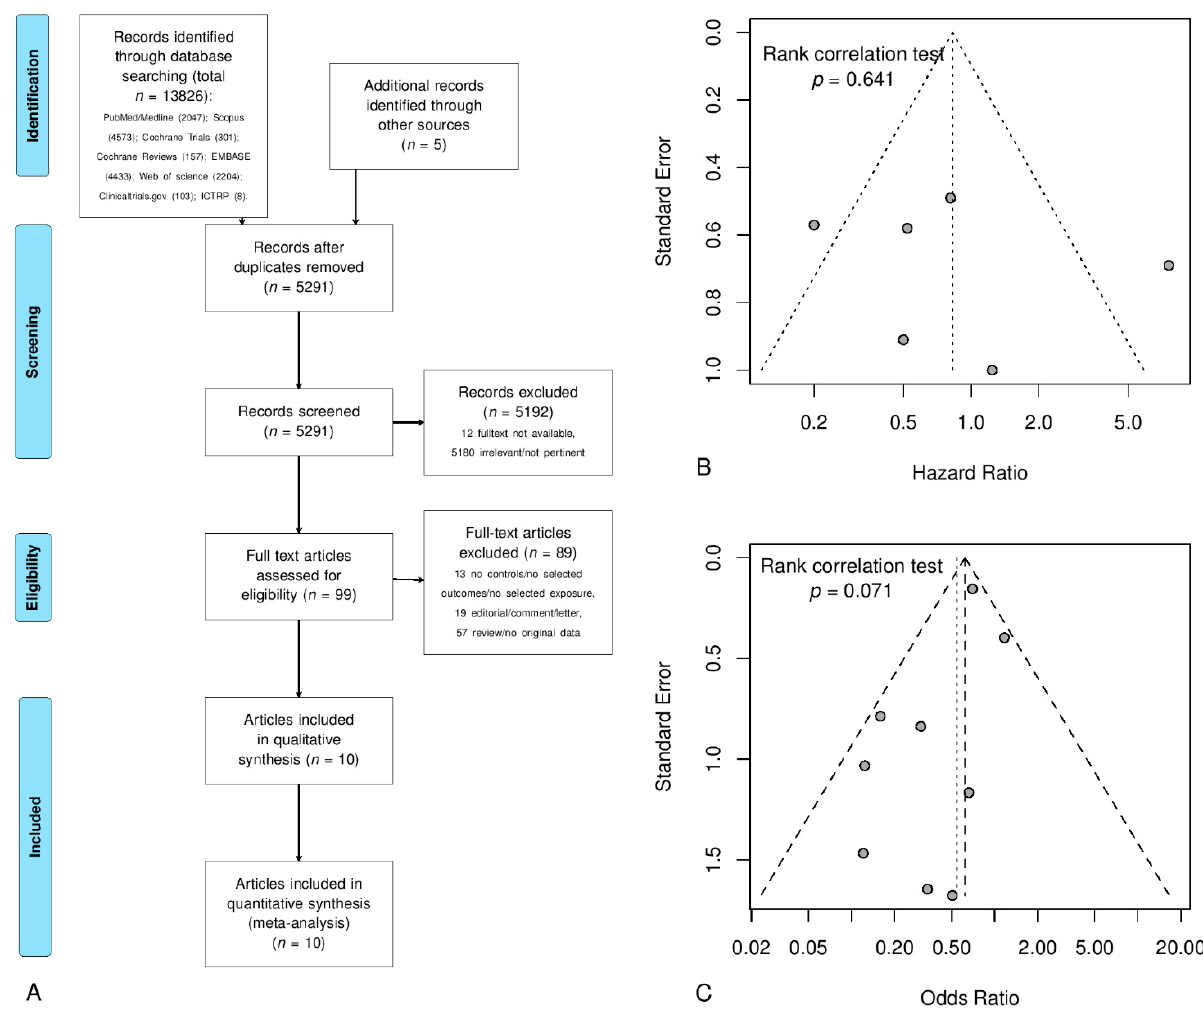
Figure 1. Panel ( A ) Flowchart of study selection process according to PRISMA guidelines. Panel ( B ) Funnel plot of hazard ratio (HR) meta-analysis for disease-free survival/recurrence risk (Rank correlation test p -value = 0.641). Panel ( C ) Funnel plot of odds ratio (OR) meta-analysis for recurrence risk (Rank correlation test p -value = 0.071).